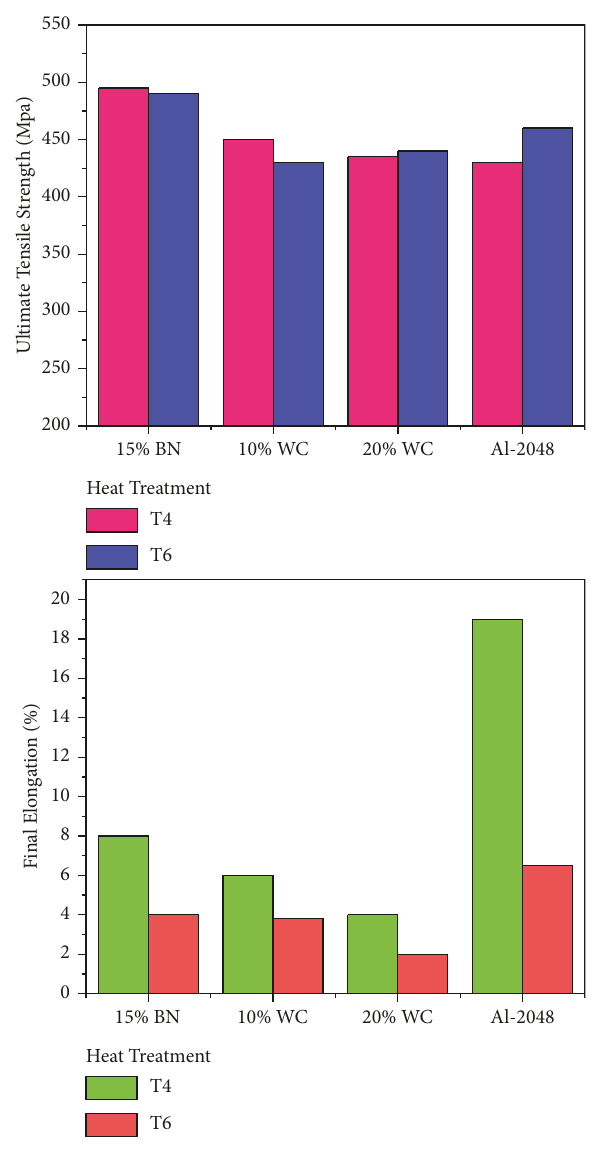
Figure 3: Comparison of UTS and final elongation of the com- posites with different heat treatments at the room temperature.